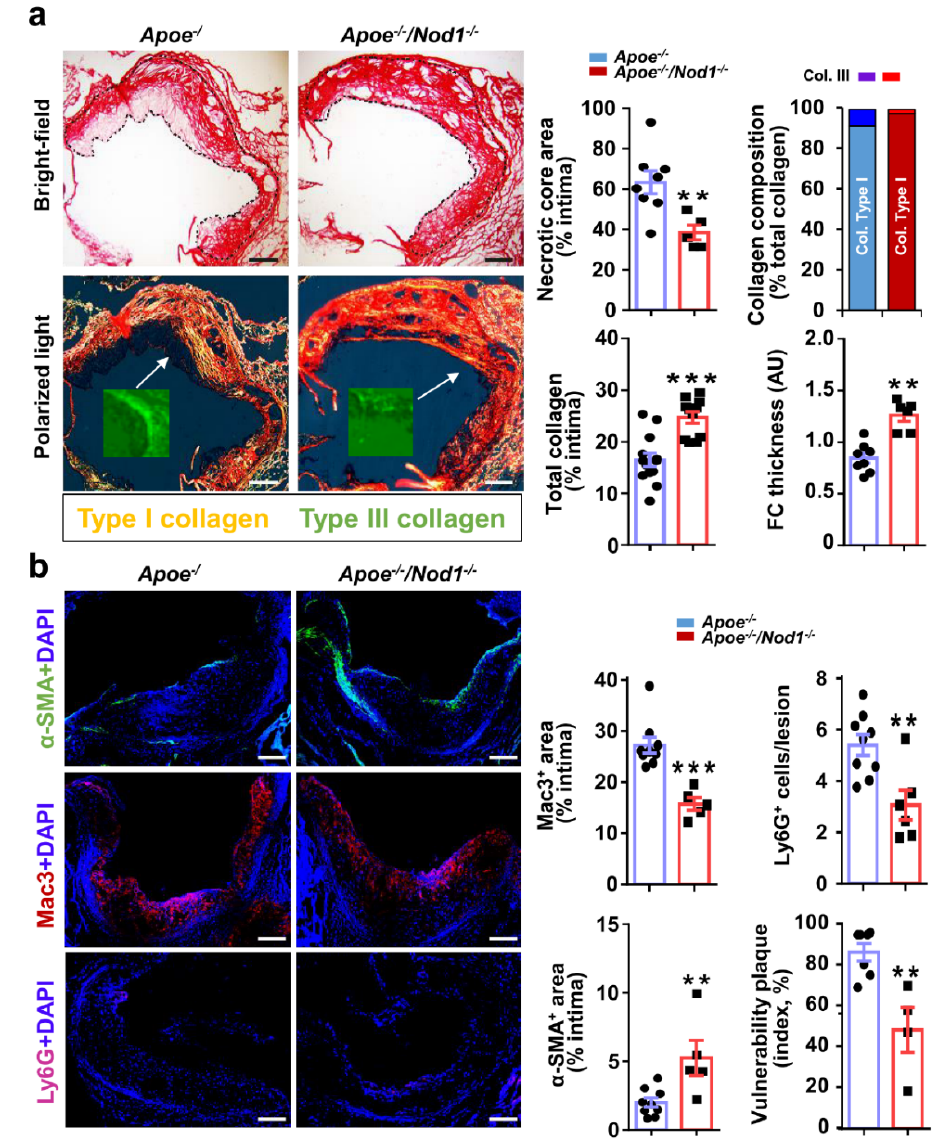
Figure 2. Nod1 deficiency in Apoe − / − mice results in decreased vulnerable plaques. ( a ) The collagen content of aortic sinus plaques in Apoe − / − ( n = 13) and Apoe − / − Nod1 − / − ( n = 11) mice fed HFD for 16 weeks was evaluated by Sirius red staining. Quantification of total collagen content, necrotic core (NC) area and fibrous cap (FC) thickness was analyzed using brightfield microscopy. Hughe birefringence under polarized light illumination allowed quantification of type I (‘mature-collagen’; orange red birefringence) or type III (‘immature-collagen’; green yellow birefringence and green image in the inset) collagen as percent of total collagen. Representative images in bright field and polarized light illumination in lesions of the aortic sinus are shown. ( b ) Quantification of macrophage, neutrophil and SMC neointimal content in the semilunar valve cusps of the same cohort of mice. Vulnerability plaque index was determined as the NC and MAC3 + areas divided by the collagen and smooth muscle α -actin ( α -SMA) + staining areas of the same lesions [24]. Representative immunofluorescence images of anti-MAC3, anti-Ly6G and anti- α -SMA staining in lesions of the aortic sinus are shown. Data are represented as mean ± s.e.m. of the indicated number ( n ) of repeats. ** p < 0.01, *** p < 0.001 vs. Apoe − / − by Student’s t test. Bars, 50 µm.